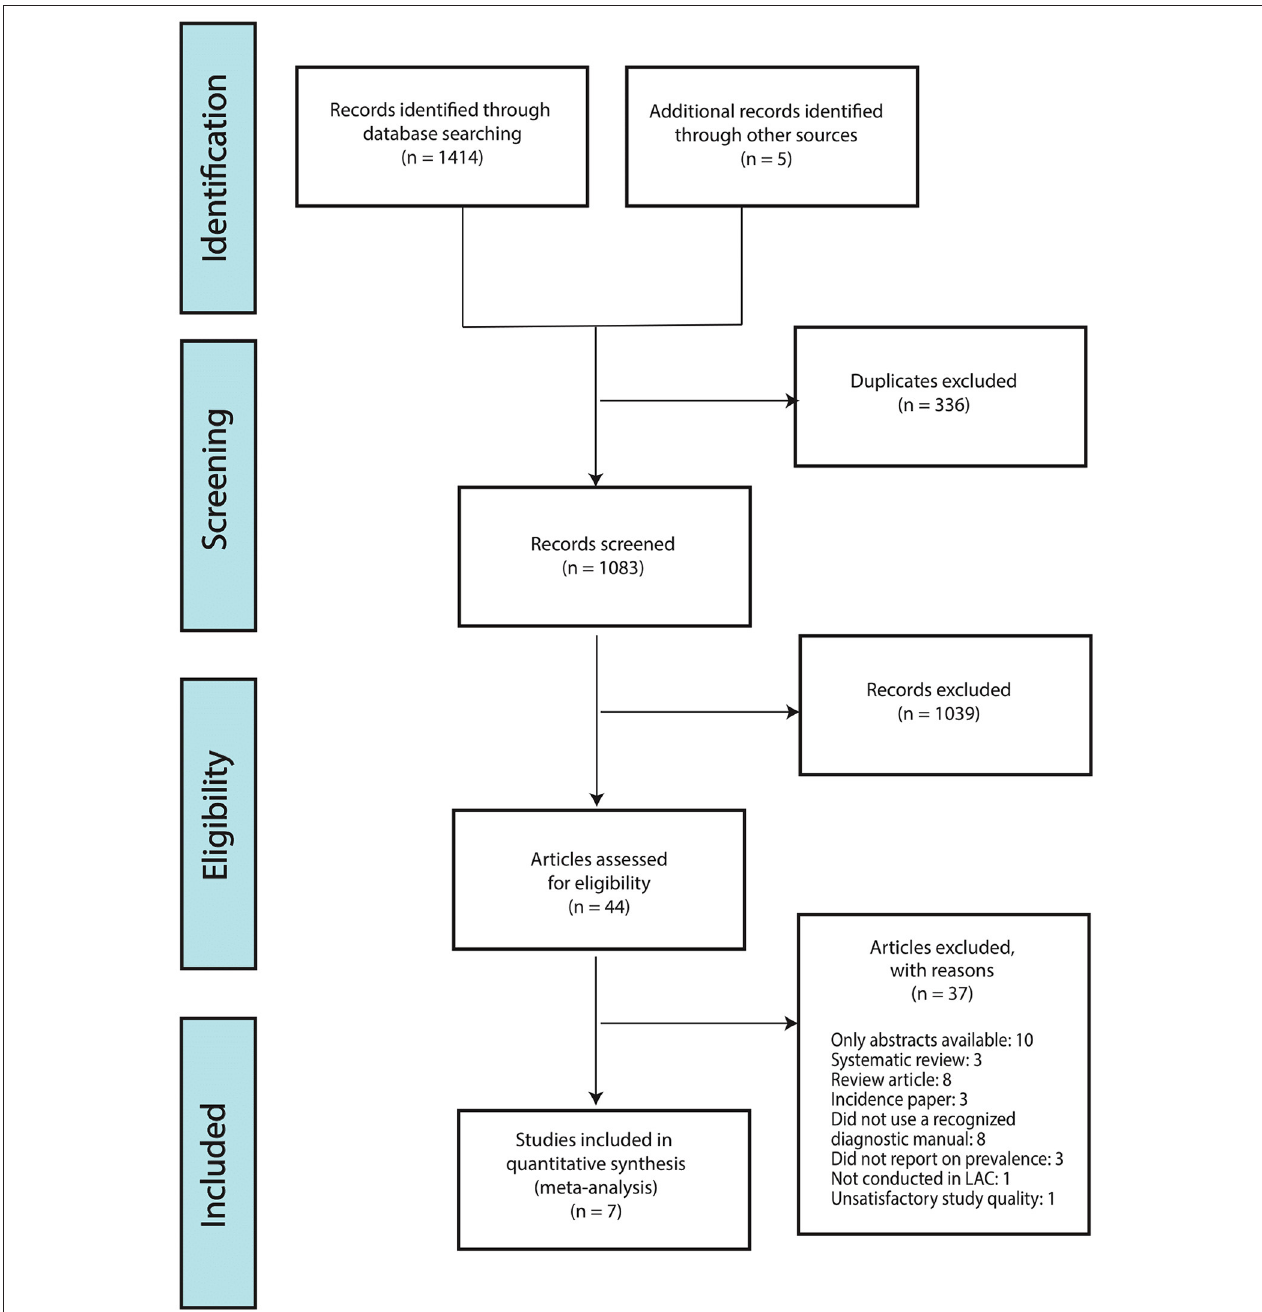
FIGURE 1 | PRISMA of study